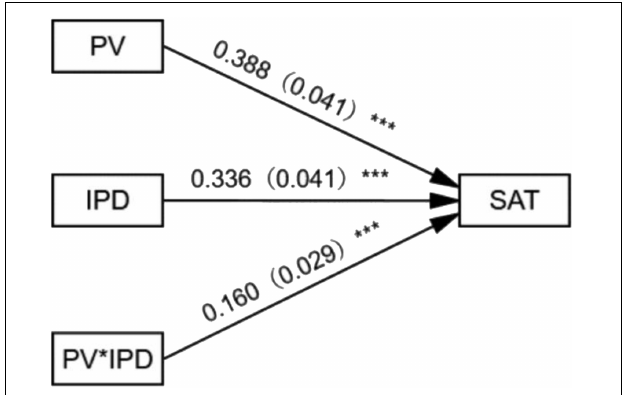
FIGURE 3 | Moderating effect of involvement in purchasing decisions on the relationship between perceived value and satisfaction. *** p <